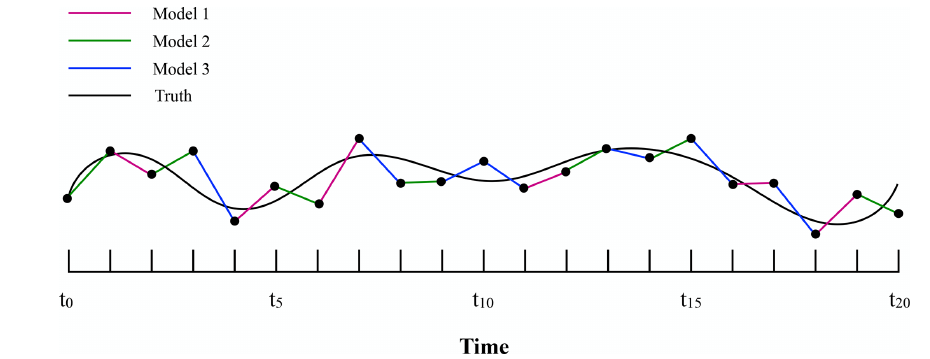
Figure 4. CPT trajectory after a training period of 20 time steps. Model 1 is used for 6 out of 20 time steps; hence, model 1 will get a weight of